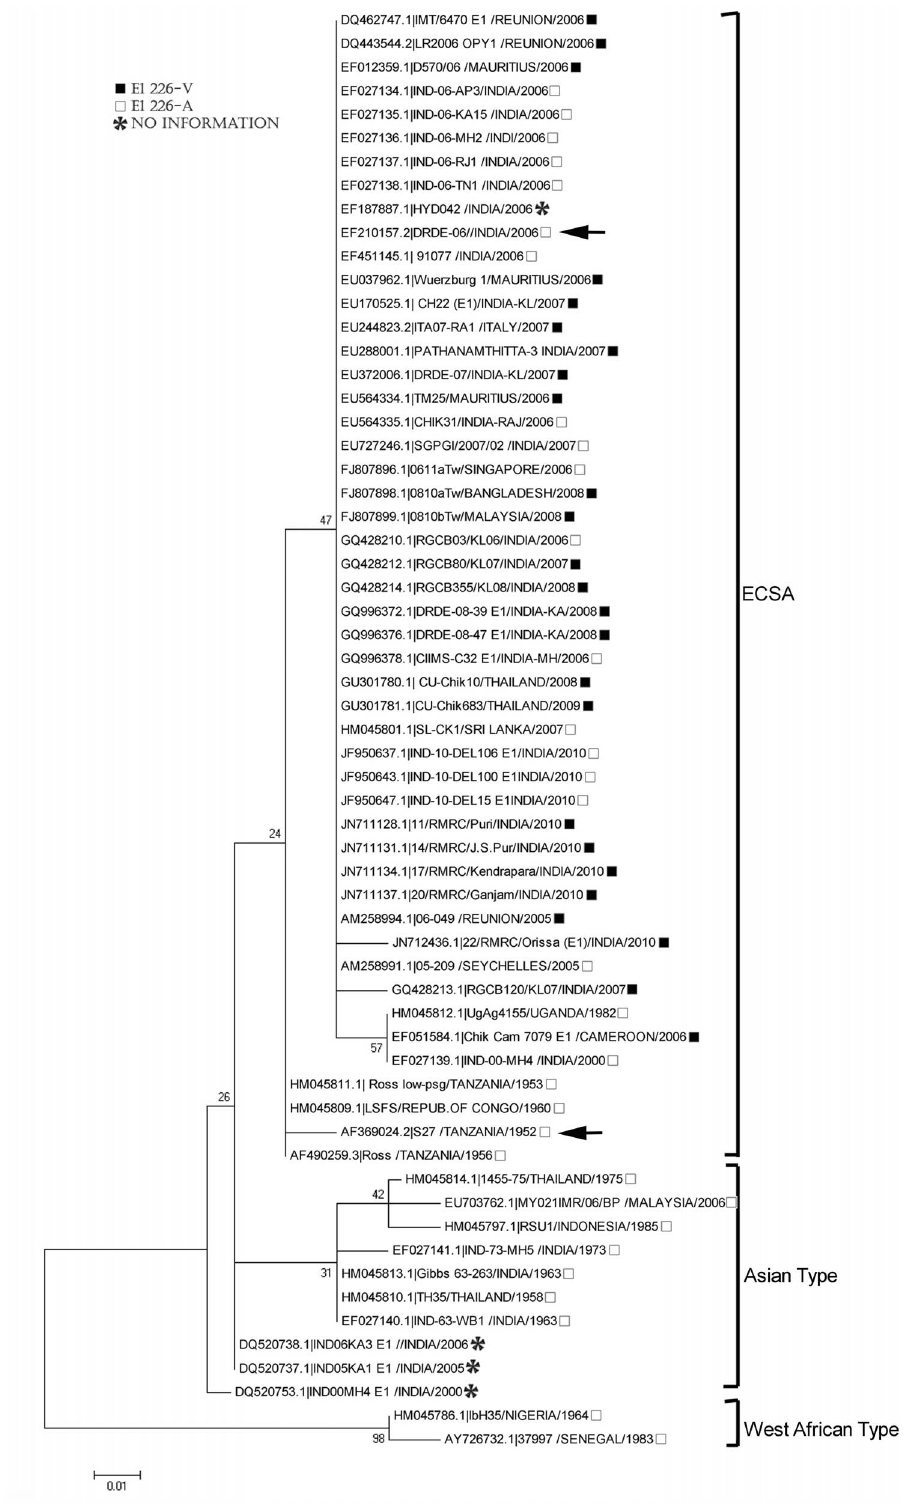
Figure 5. Phylogenetic analysis of E1 sequences of 61 representative Chikungunya viruses global isolates from the year 1952 to 2011. The unrooted tree was constructed using Neighbor-Joining method with 1000 bootstrap value. Numbers along with branches indicate bootstrap values. Scale bar indicates nucleotides substitutions per site. The presence/absence of E1-A226V mutation is depicted by black filled square and open square. *indicates the unavailability of sequence information for E1-A226V mutation and Arrow indicates strains used in this study. (The full Phylogenetic tree of 106 global isolates from the year 1952 to 2011 may be viewed in Figure S3).